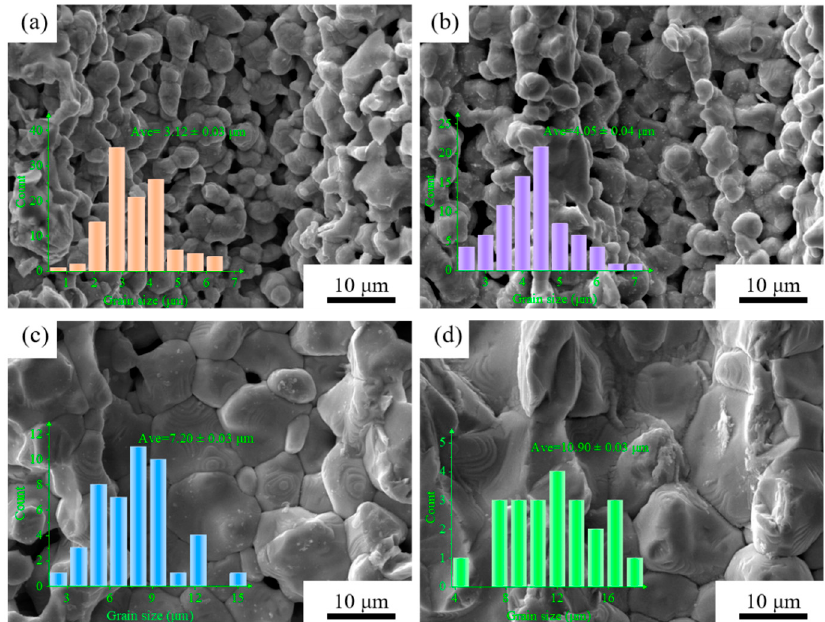
Figure 4. Pore walls of porous BCZT piezoelectric ceramics at different sintering temperatures: ( a ) 1300 °C, ( b ) 1350 °C, ( c ) 1400 °C, ( d ) 1450 °C.